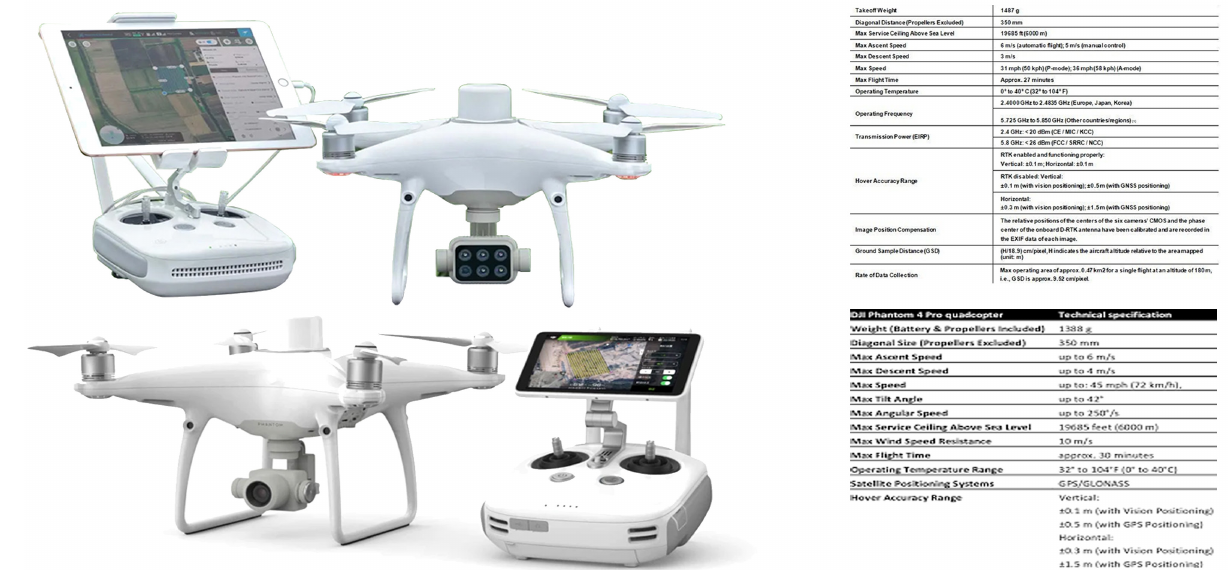
Figure 1. Low-Cost UAV systems: DJI ® Phantom 4 Multispectral and DJI ® Phantom 4 Pro